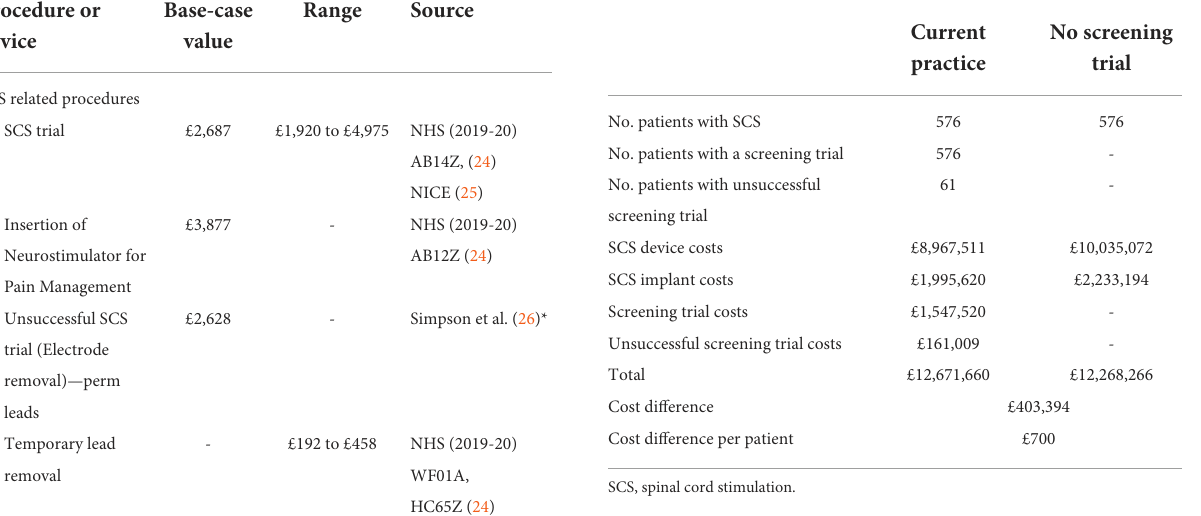
TABLE 1 Procedure and device costs. TABLE 2 Difference in current practice and a no screening trial strategy for the year